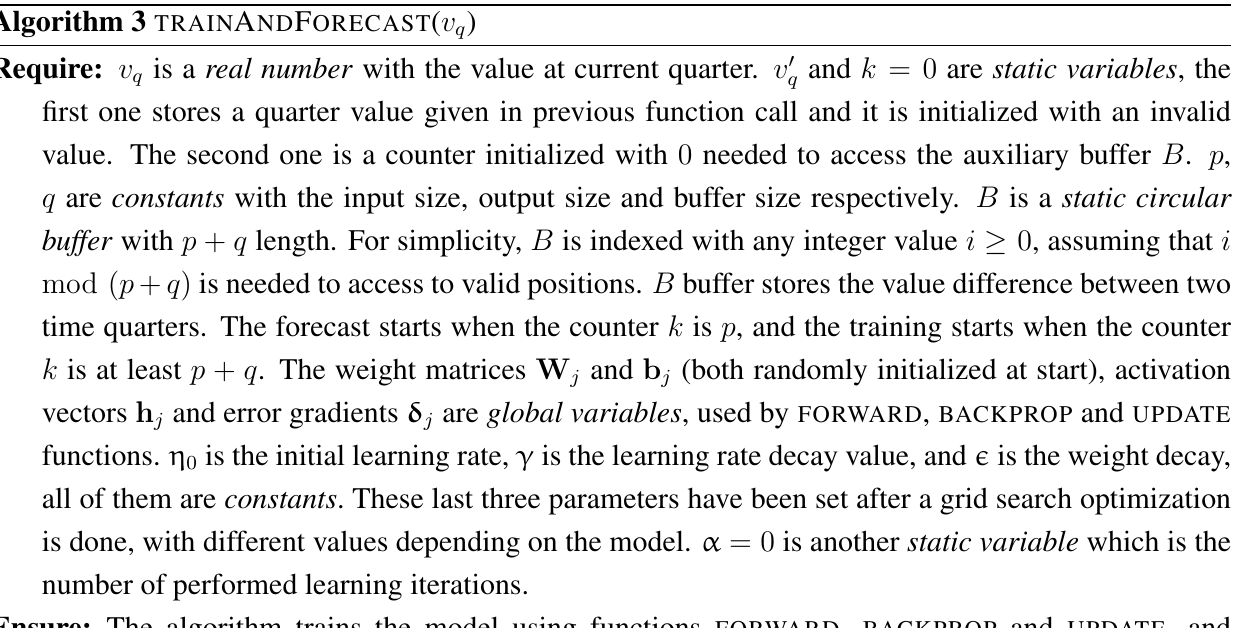
Algorithm 3 TRAIN A ND F ORECAST ( v